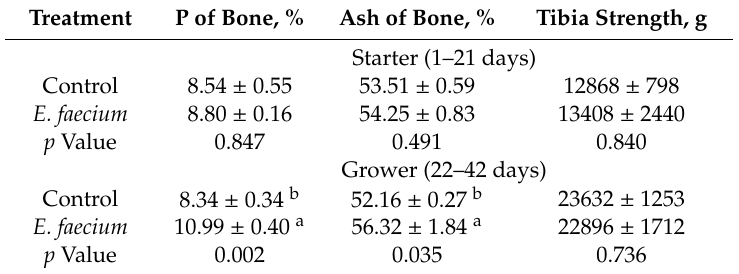
Table 5. Dietary E. faecium supplementation on P and ash content of bone, ash of bone and tibia strength of broilers.